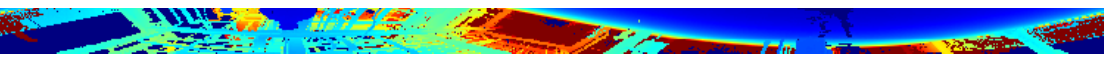
Figure 8. Example of a 360 ◦ range image obtained by projecting the point cloud of Figure 2 onto a 2D grid. The blue color means that points are close-by, whereas the red color denotes that points are located further